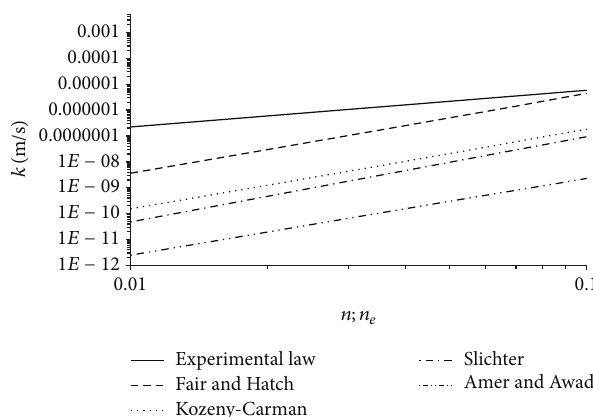
Figure 7: Trends of the experimental law 𝑘 = 𝑘(𝑛 𝑒 ) and semiempiri- cal formulae of Kozeny-Carman, Slichter, Fair and Hatch, and Amer and Awad for the considered aquifer.